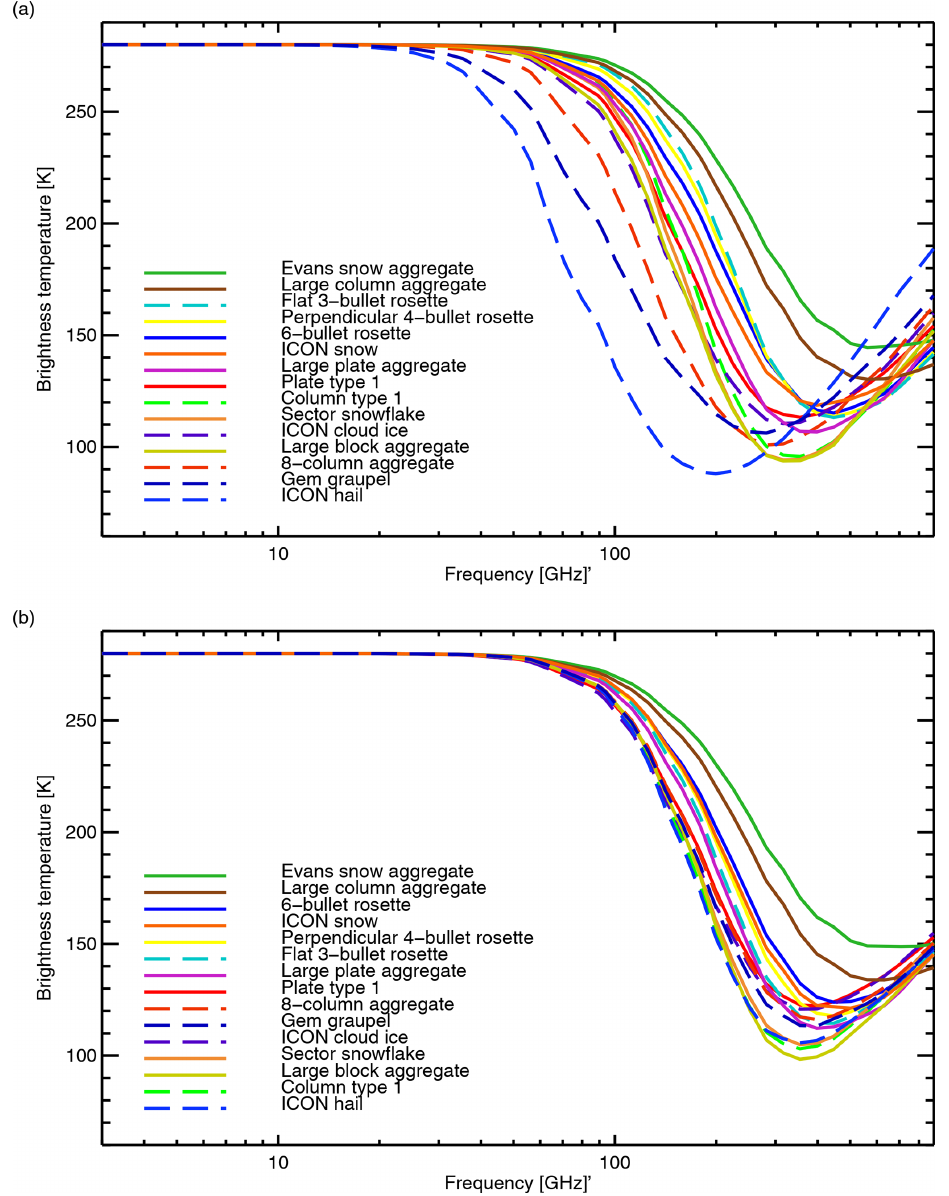
Figure 12. Brightness temperatures from a standard snow or ice cloud; details as Fig. 9a but exploring different PSDs: (a) Heymsfield et al. (2013, H13); (b) McFarquhar and Heymsfield (1997,